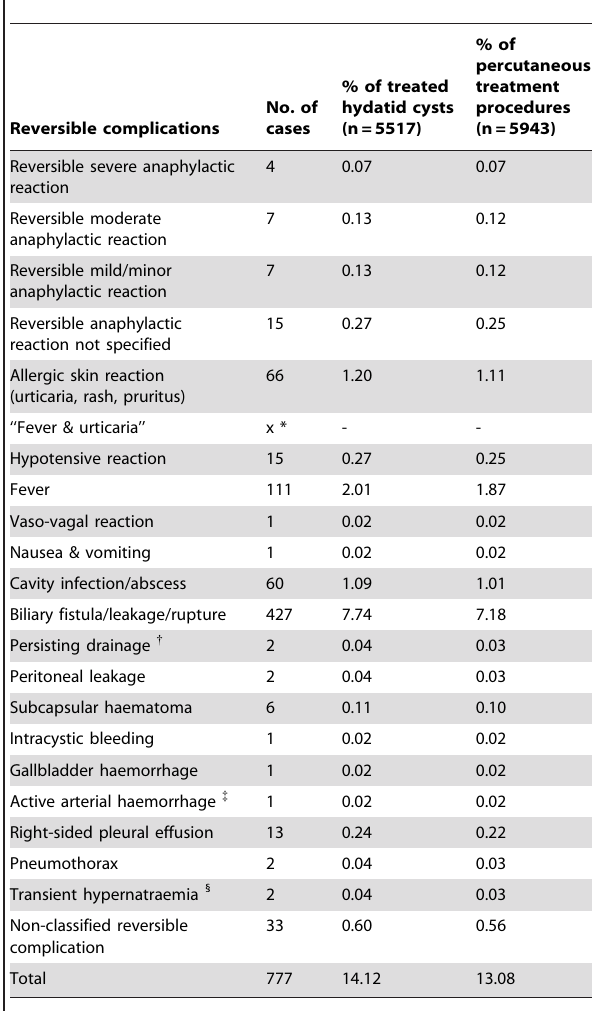
Table 5. Reversible complications due to percutaneous treatment of extra-hepatic hydatid cysts.